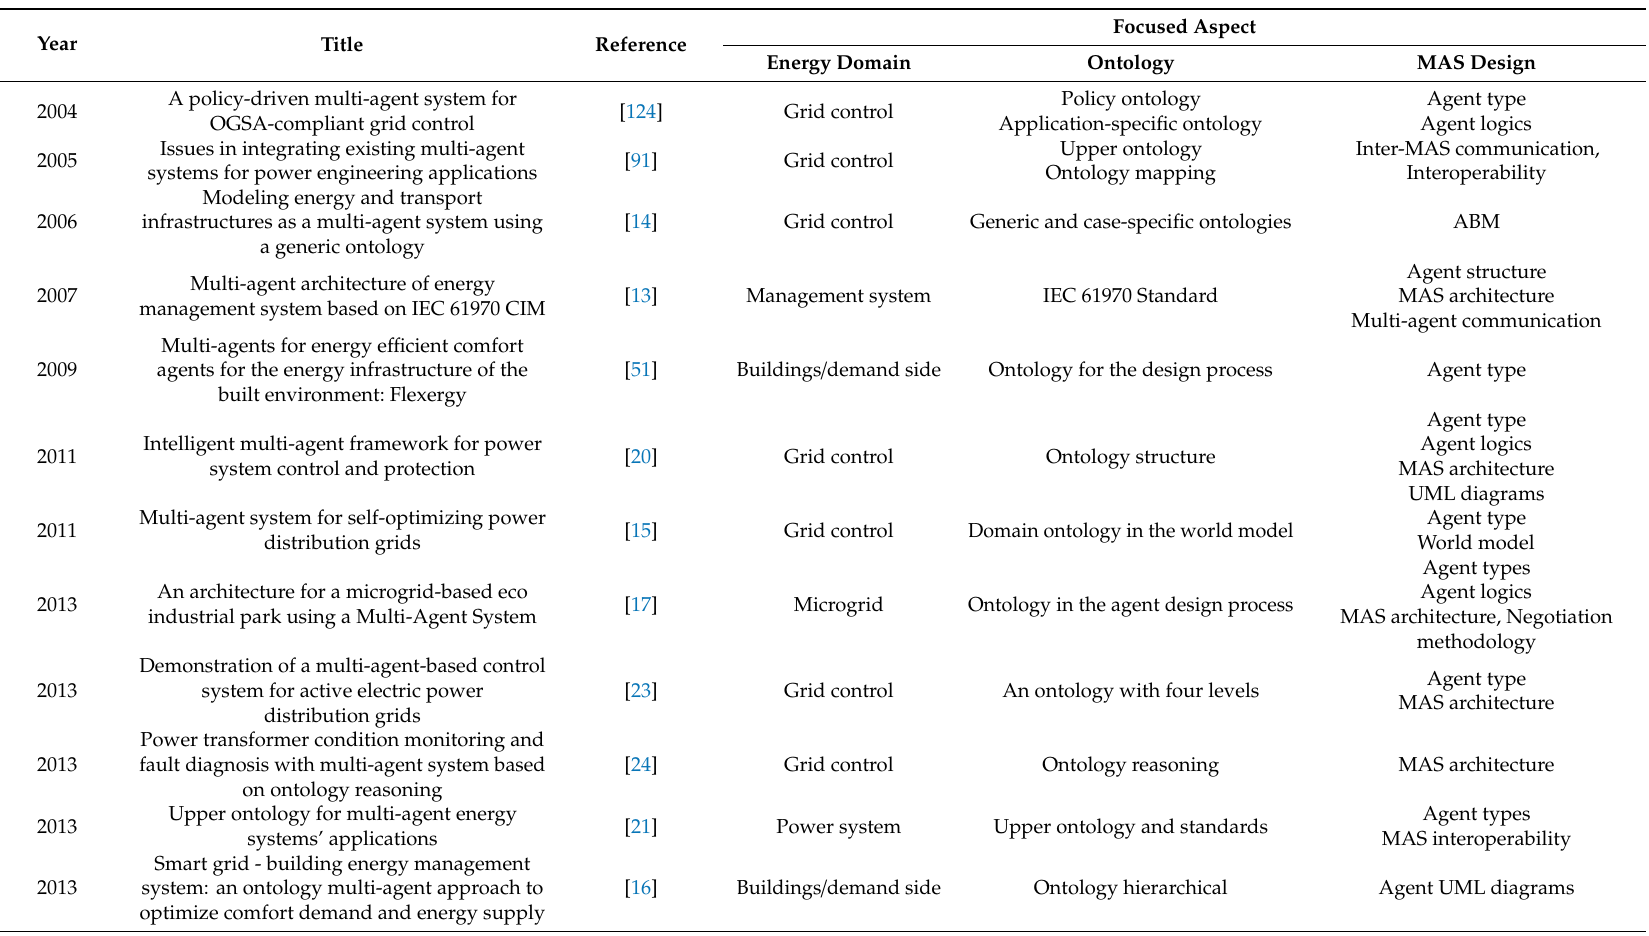
Table A1. Selected publication and their focus